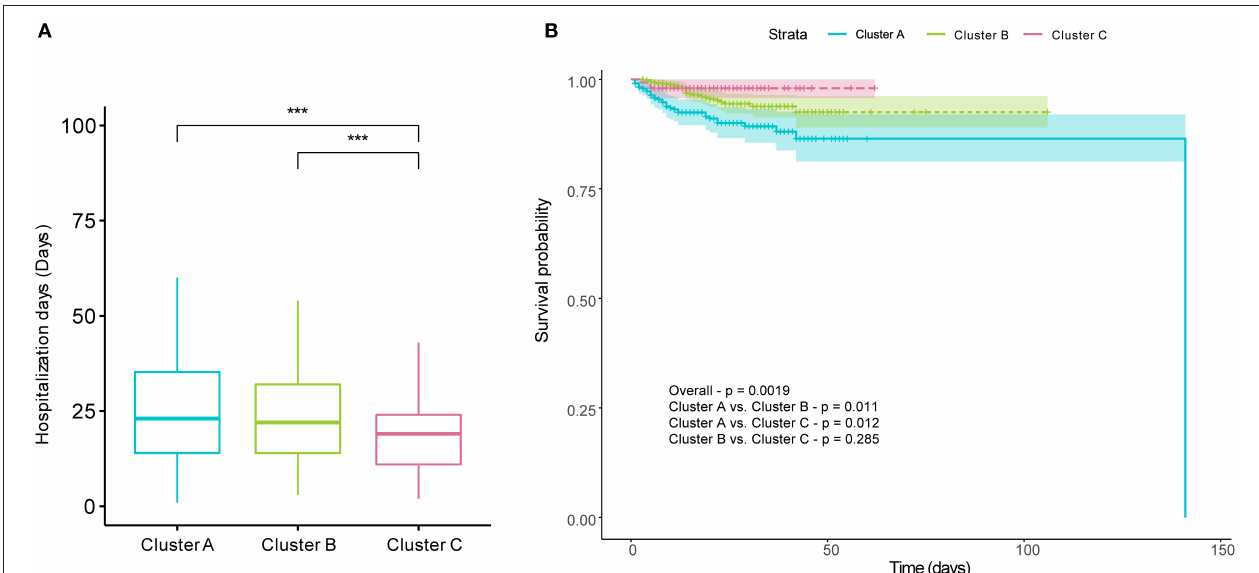
FIGURE 6 | Prognosis differences of COVID-19 patients among the three clusters. There were significant differences in hospitalization days between Clusters A and C and between Clusters B and C (A) . (B) shows cumulative survival curves of three clusters comparing the survival probabilities among the three clusters, with shaded areas representing 95% confidence intervals. There were significant differences in the Kaplan–Meier survival curves between Clusters A and B, and between Clusters A and C. The Kruskal–Wallis test with Dunn’s posttest and log-rank test were used to for comparisons, and p -values were adjusted by the Benjamini–Hochberg procedure. * p < 0.05; ** p < 0.01; *** p < 0.001; **** p < 0.0001; All represents the range of adjusted p values in (A)